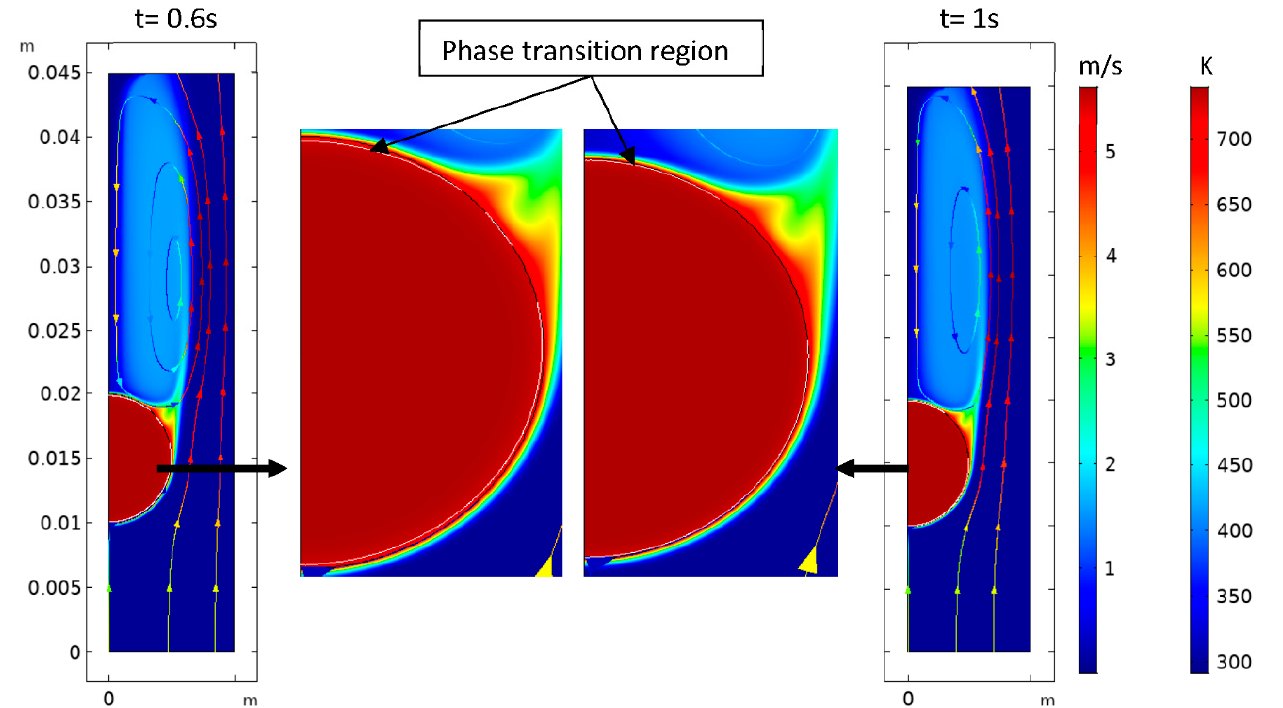
Figure 5. Temperature distribution of N 2 and the droplet (AgCl) domain with a droplet radius of 0.005 m.